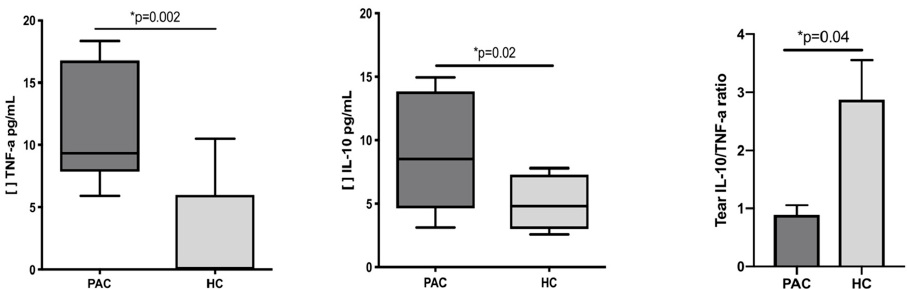
0.002 Kit detection limits were as follows: IL-8, 3.8 pg/mL; IL-1 β , 7.2 pg/mL; IL-6, 2.5 pg/mL; IL-10, 3.3 pg/mL; TNF- α , 3.7 pg/mL; and IL-12p70, 1.9 pg/mL. * Results below the limit of detection were considered as 0 for comparison between groups.